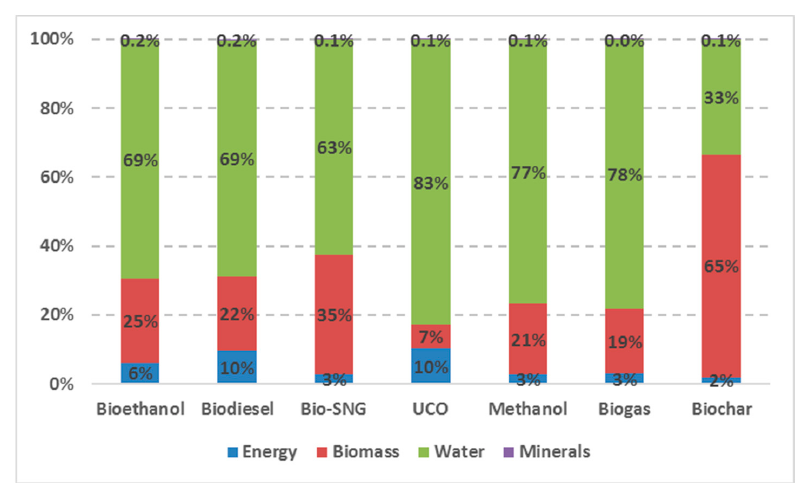
Figure 6. Resource contributions to the exergy cost of bioproducts (crop to fuel). Note: For biogas production only biomass derived from crops (and not waste, for example) were taken into consideration.